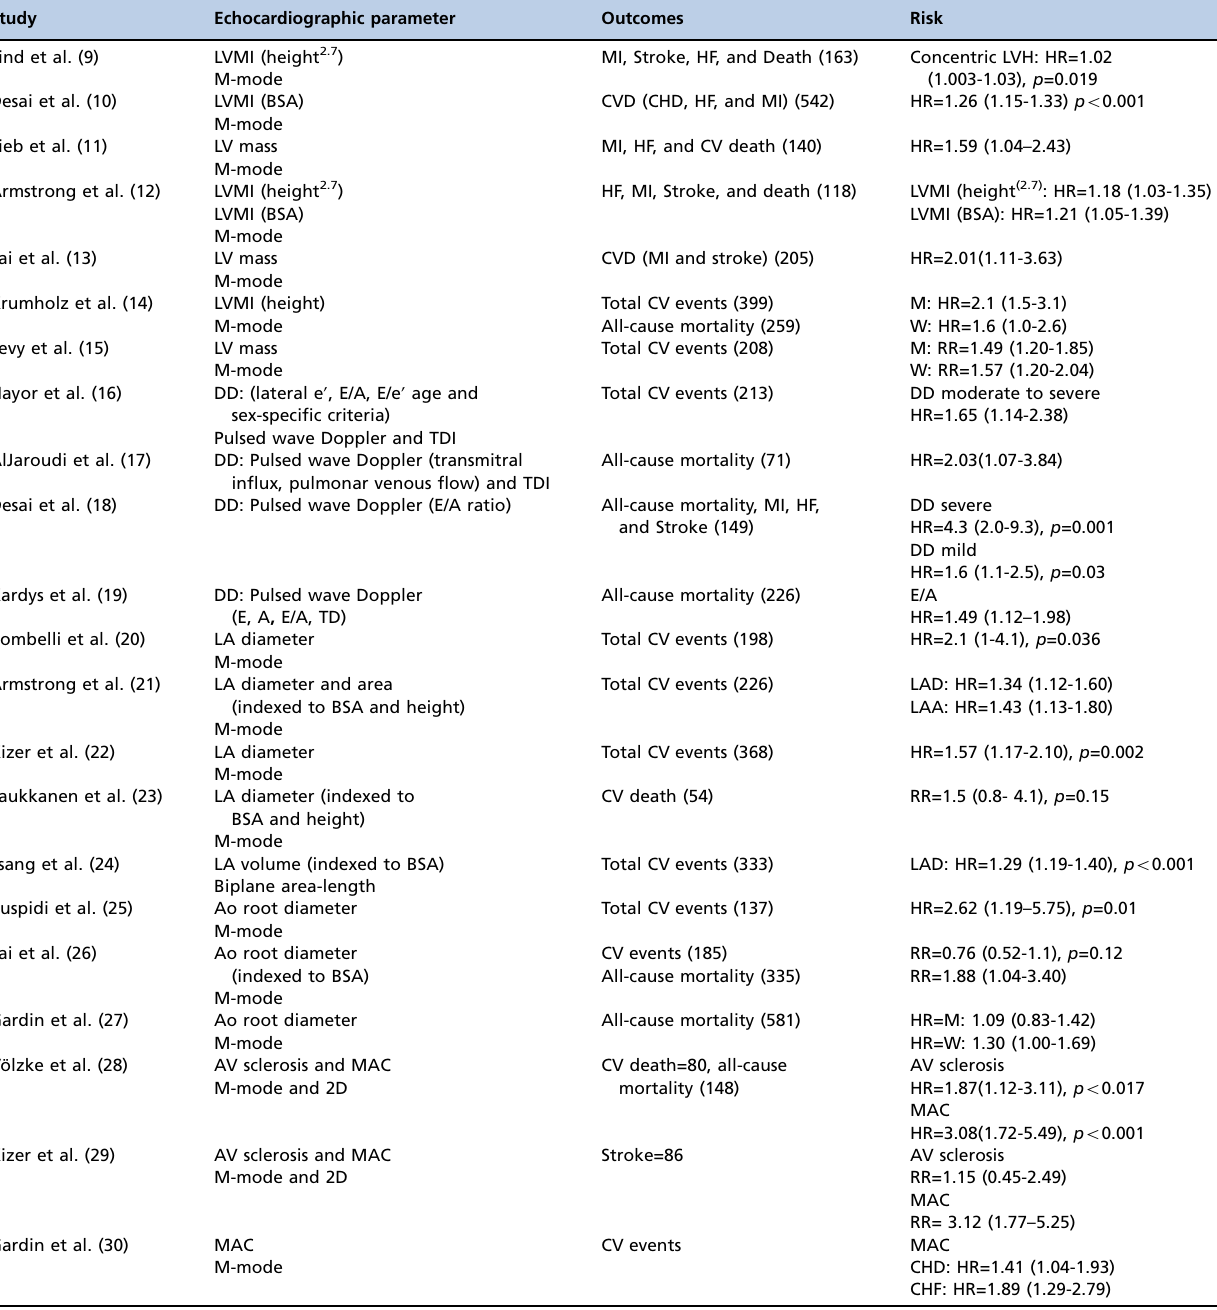
Table S3 - Methods used to assess echocardiographic abnormalities, cardiovascular outcomes and risk found in the selected